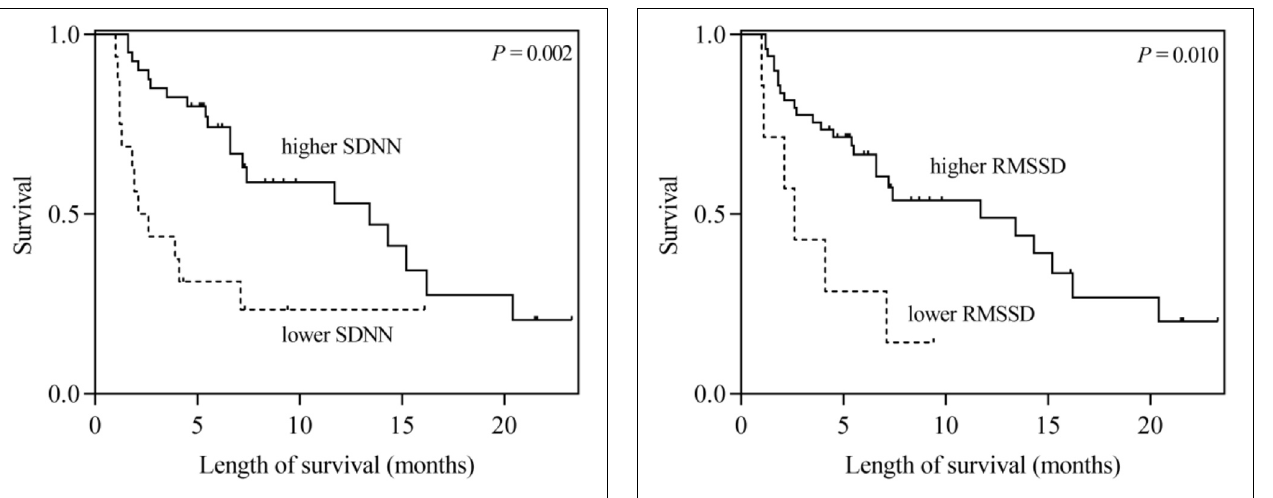
FIGURE 1 | Kaplan–Meier survival curves for LCBM patients with SDNN ≤ 13 ms versus those with SDNN > 13 ms.